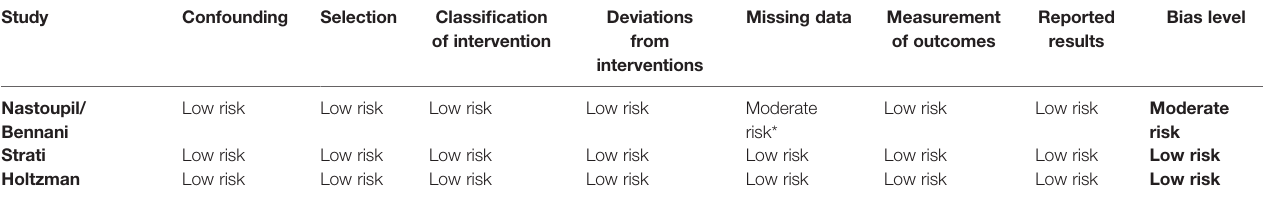
TABLE 4 | The quality assessment for included cohort